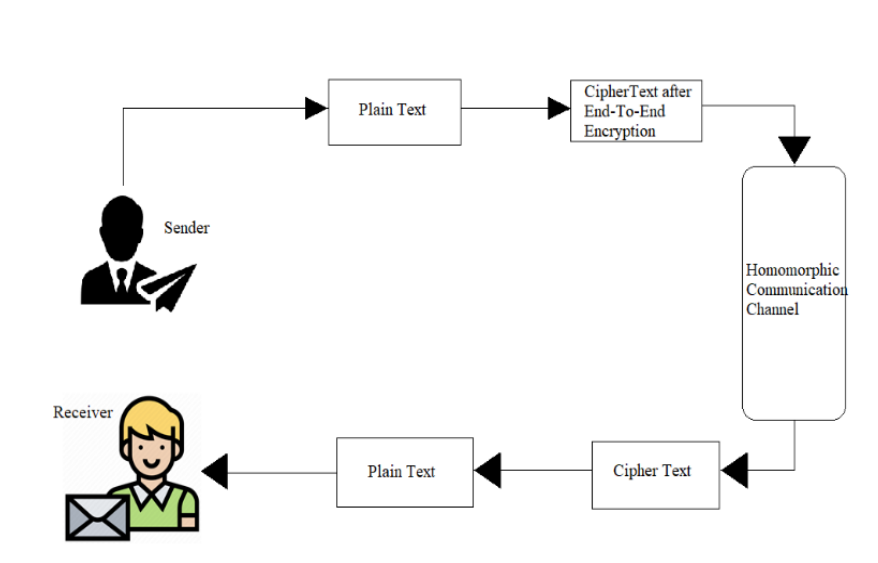
Figure 1. System